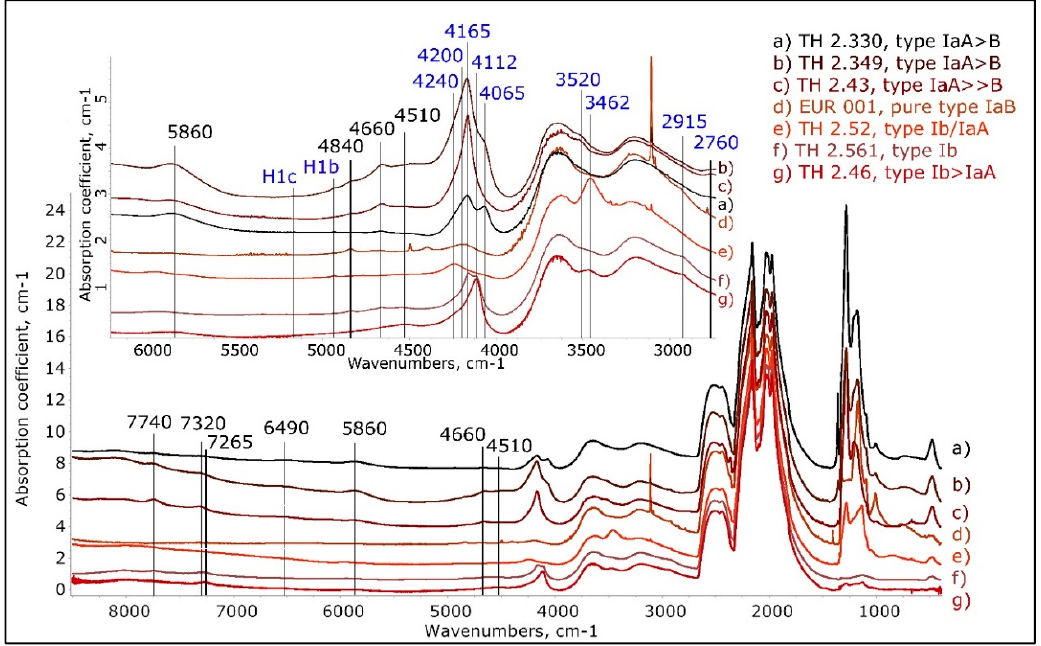
Figure 5. Representative normalized infrared spectra showing the different types of amber centers (ACs) in brown diamonds, recorded at room temperature. Type Ia diamonds show either an AC with the main absorption at 4165 cm − 1 or a “double AC” having a double band at 4165 and 4065 cm − 1 (traces a, b, and c), with weak bands at 3520 and 2760 cm − 1 when the 4165 cm − 1 AC is strong; in the spectra of type Ib diamonds, there is a either a single main band at 4112 cm − 1 or a double band at 4165 and 4112 cm − 1 , sometimes with a 3462 cm − 1 and a 2915 cm − 1 AC (traces e, f, and g); in some type Ib DR brown diamonds, a band at 4240 cm − 1 is distinct; it is unclear whether it is another AC zero phonon line (ZPL) or a component of the 3462 cm − 1 AC (traces e and g). The spectra were shifted vertically for clarity.